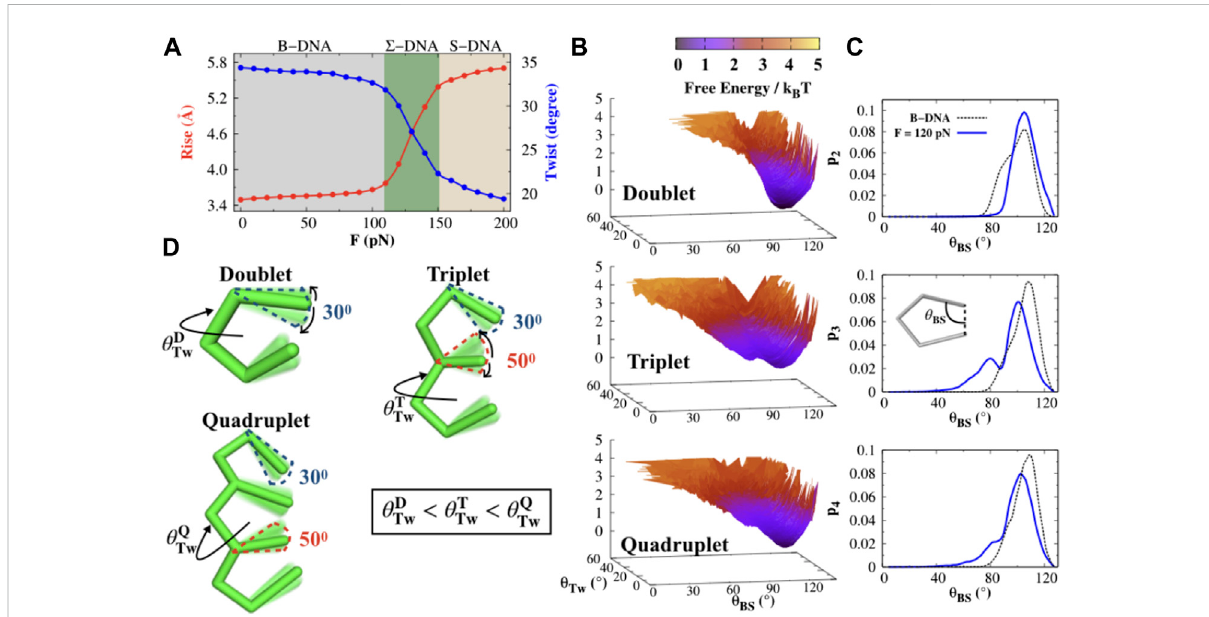
FIGURE 2 Structural characterization of the DNA bases. (A) DNA helical rise and twist angles are calculated as a function of stretching force F. The three shadedregionsgray, green,andyellowcorrespondto threedifferentDNAconformations, namely,B-, Σ -,andS-DNA thatemergedueto stretching. Theerror barforeachsymbolisde fi ned asthestandarderror. The associatederror barsaresmaller thanthepointsize. (B) Free energypro fi les F ( θ Tw , θ BS ) for the doublet, triplet, and quadruplet at force F = 120 pN, where θ Tw and θ BS are the helical twist and base-stacking angles. (C) Probability histograms of the base-stacking angles ( θ BS ) for the doublet ( p 2 ), triplet ( p 3 ), and quadruplet ( p 4 ) at a stretching force F = 120 pN (blue solid line) compared with B-DNA (dashed line). (D) Schematic representation of the structure of the doublet, triplet, and quadruplet. The twist angles for the doublet ( θ D Tw ) , triplet ( θ T Tw ) , and quadruplet ( θ Q Tw ) are shown by black arrows that follow a relation speci fi ed in the rectangular box. The fl uctuation in each base for the doublet, triplet, and quadruplet is shown by a blurred motion view. The range of angles of the bases that arise due to fl uctuation is displayed